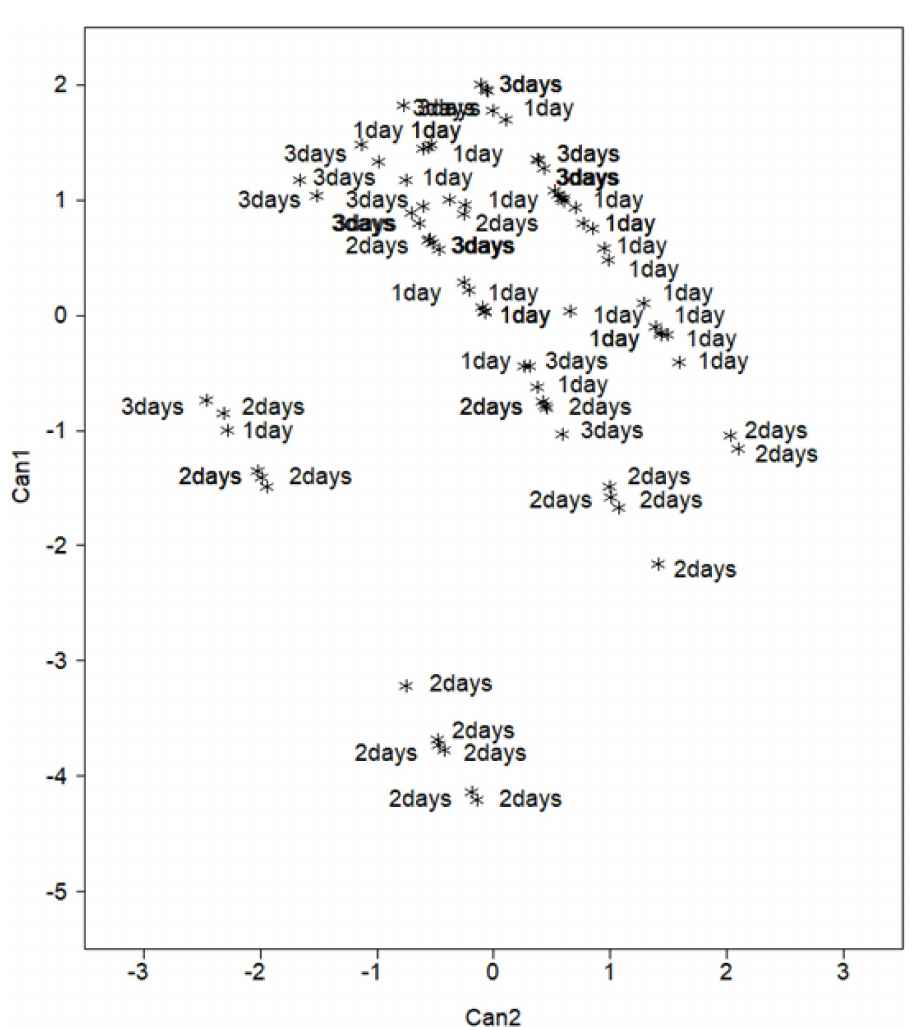
Figure 2. Scatter plot of centroids (class means) for the first and second canonical variates separating the fatty acid profiles of the northern Largemouth Bass whole body samples by diet (Trial 2). Treat- ments designated as 1: Fed daily (1 day), 2: fed every second day (2 days), and 3: fed every third day (3